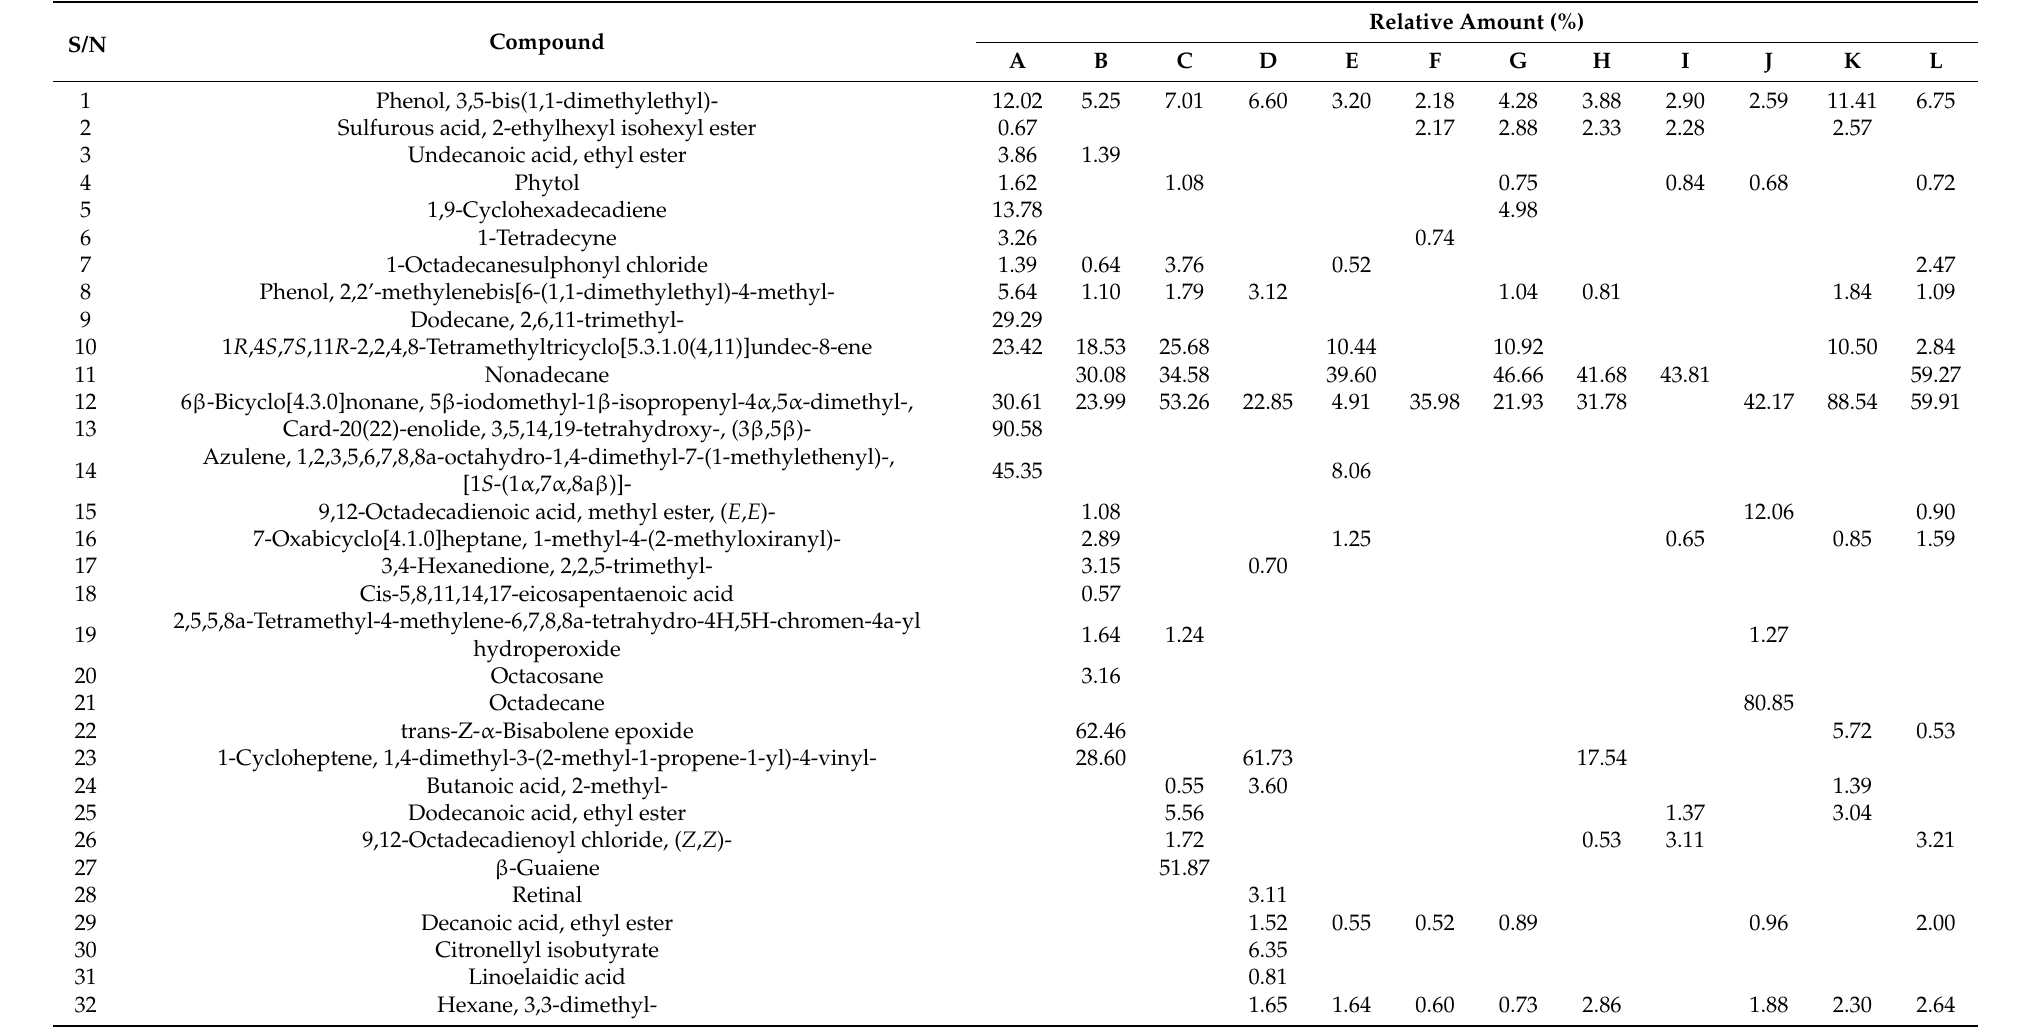
Table 3. Chemical compositions of the ethanol extractives of Alnus cremastogyne